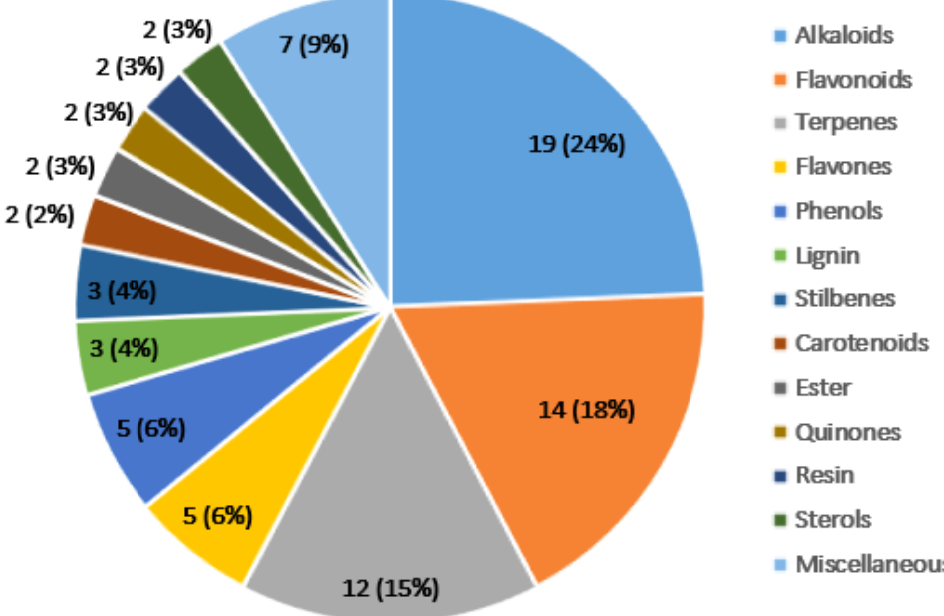
Figure 3. Numbers and percentages of anticancer phytochemicals belonging to different phytochemical classes. In this review, most phytochemicals were found to be constituted of alkaloids followed by flavonoids, terpenes, flavones, and phenols. The phytochemicals classes that have less than two phytochemicals are included in the miscellaneous class.